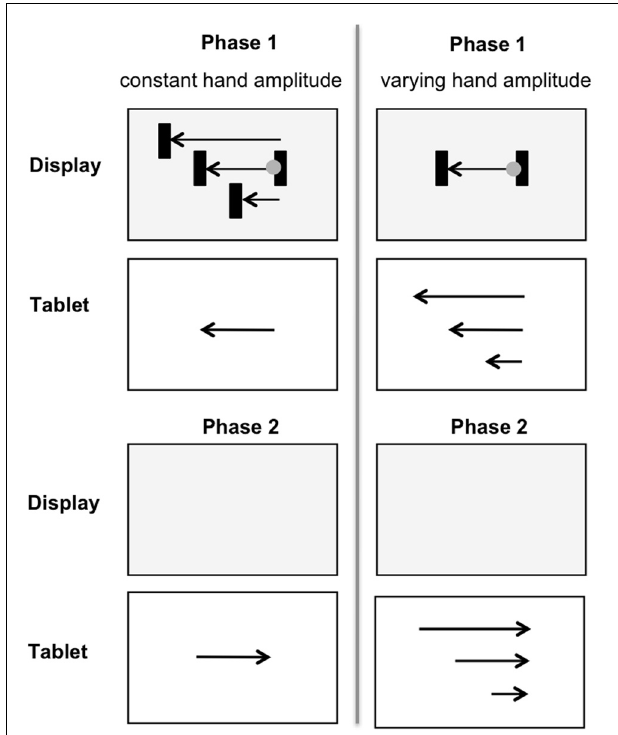
FIGURE 1 | Inphase1(upperpart)cursoramplitudeswereshorter,equal to, or longer than the constant hand amplitude (left) or cursor amplitudes remained constant across trials, while the hand amplitude was shorter, equal to, or longer (right). In phase 2 (lower part) the initially performed hand amplitude was replicated without any visual